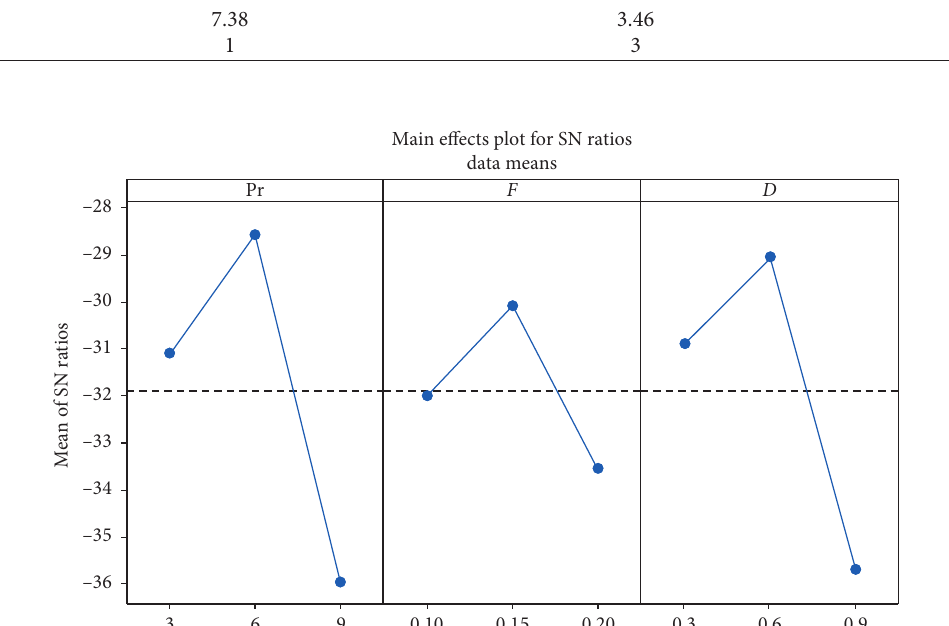
Figure 8: Thrust force-based important diagram based on the ratio of SN; in the X -axis, Pr denotes pressure of cutting fluid (bar), F denotes feed (mm/rev), and D denotes depth of cut (mm).